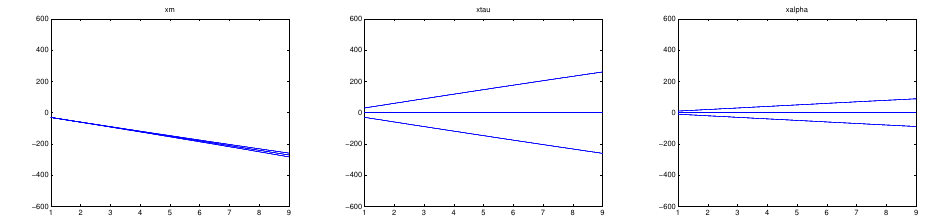
Fig. 16 Sensitivity of x with respect (left to right) the parameters m , τ and α .